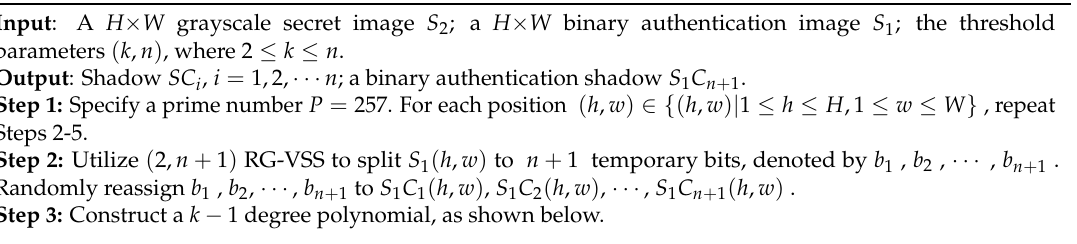
Algorithm 2 The proposed secret image sharing for ( k , n ) threshold authentication with dealer-participatory and non-dealer-participatory mutual shadow authentication